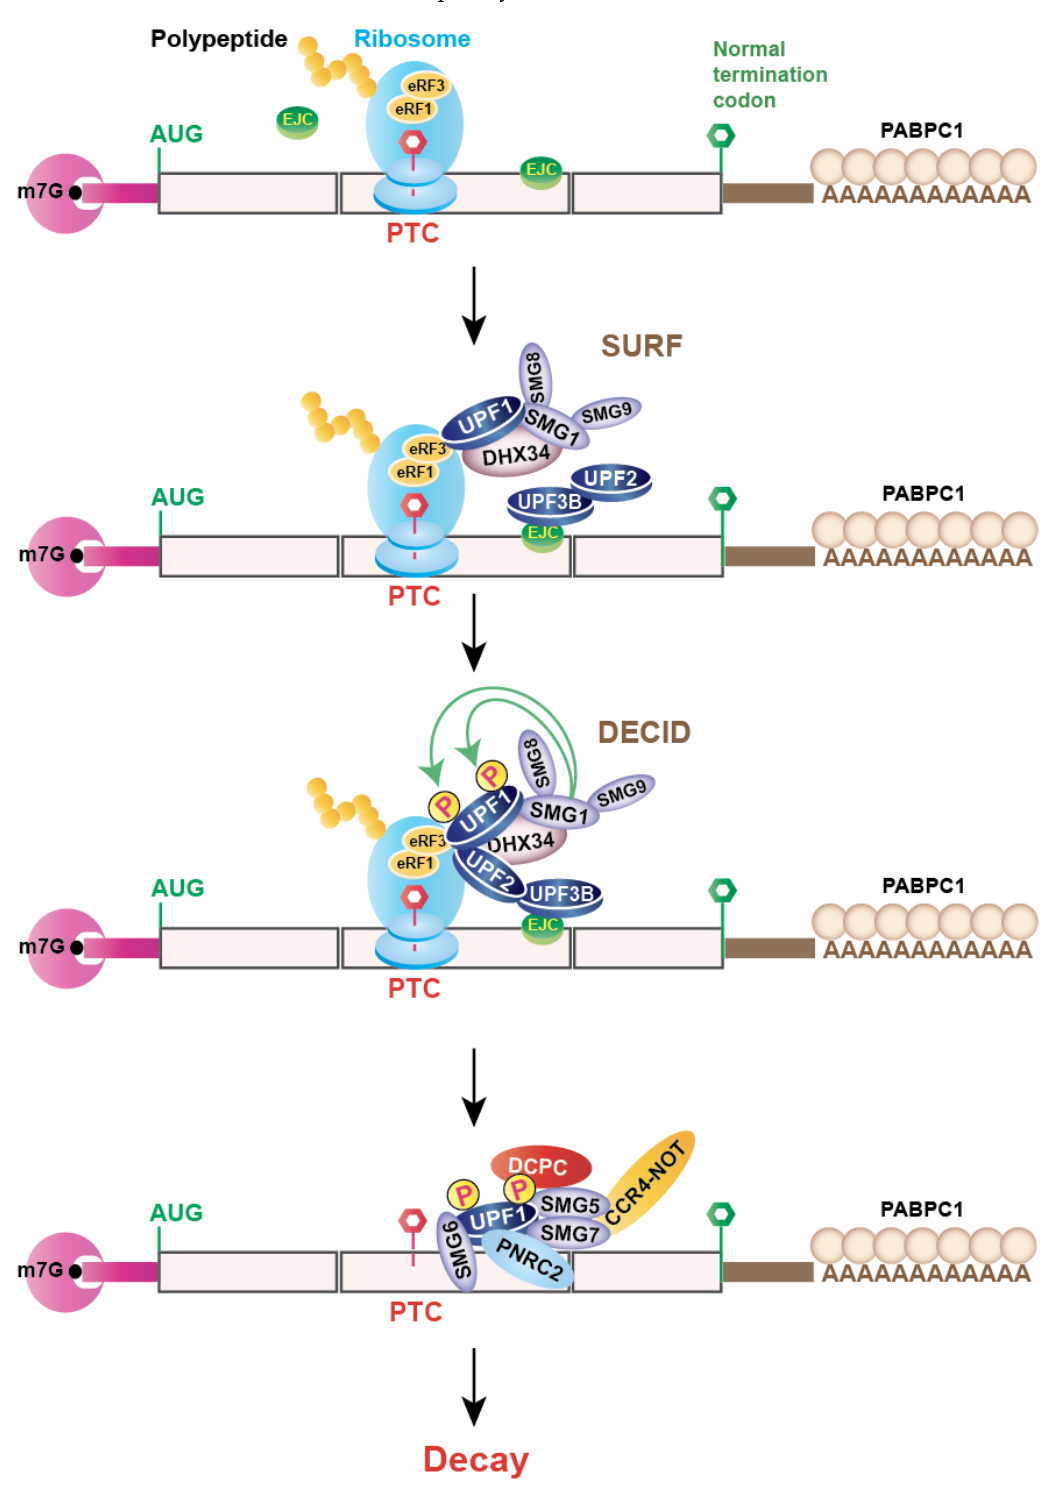
Figure 2. Schematics of the nonsense-mediated mRNA decay (NMD) pathway in mammalian cells. When a translating ribosome encounters a premature termination codon (PTC), the core NMD factor UPF1 interacts with the eukaryotic release factors eRF1 and eRF3, bound to the terminating ribo- some, and induces premature translation termination. After this, the SURF complex is formed with SMG1 associated with SMG8 and SMG9, UPF1, eRF1, and eRF3. The SURF complex is then trans- formed into a decay-inducing complex (DECID), where UPF1 interacts with UPF2-UPF3B, either